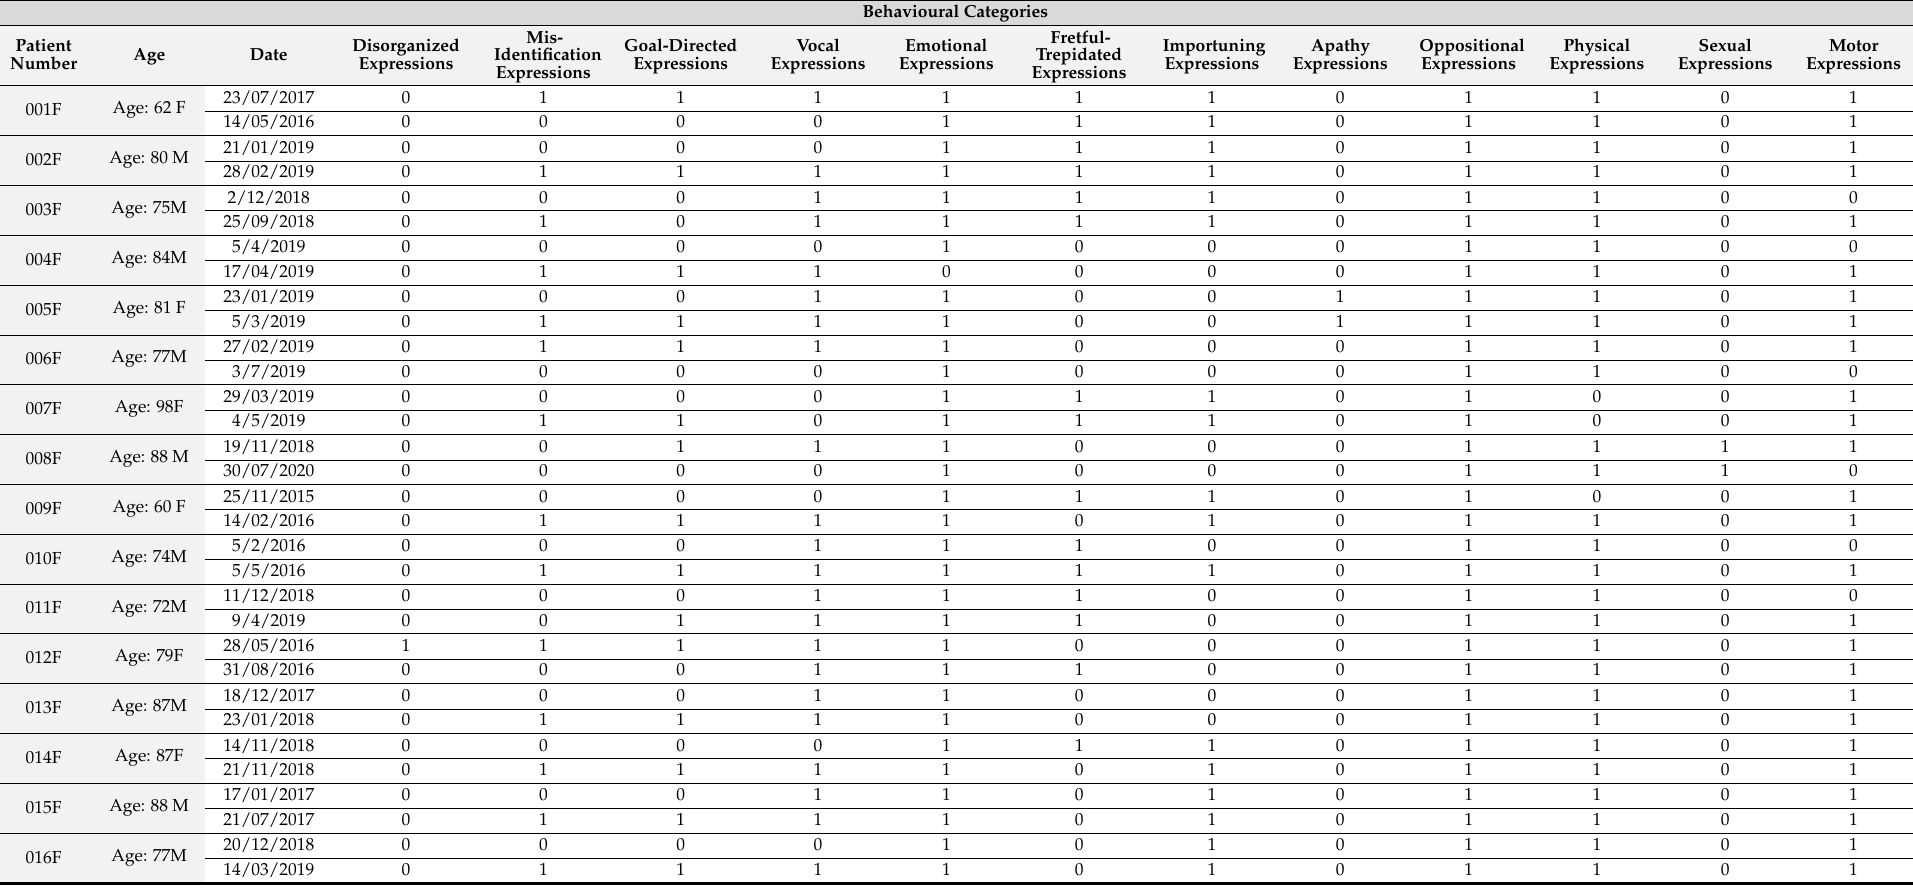
Table 3. Individual Demographics and Behavioral Categories in Failed De-prescribing group. Columns show the individual patient’s demographics of identification number, age, and the initial and the second date of data collection. Rows show the individual behavioral categories with 0 representing the absence of the category and 1 representing the presence of the